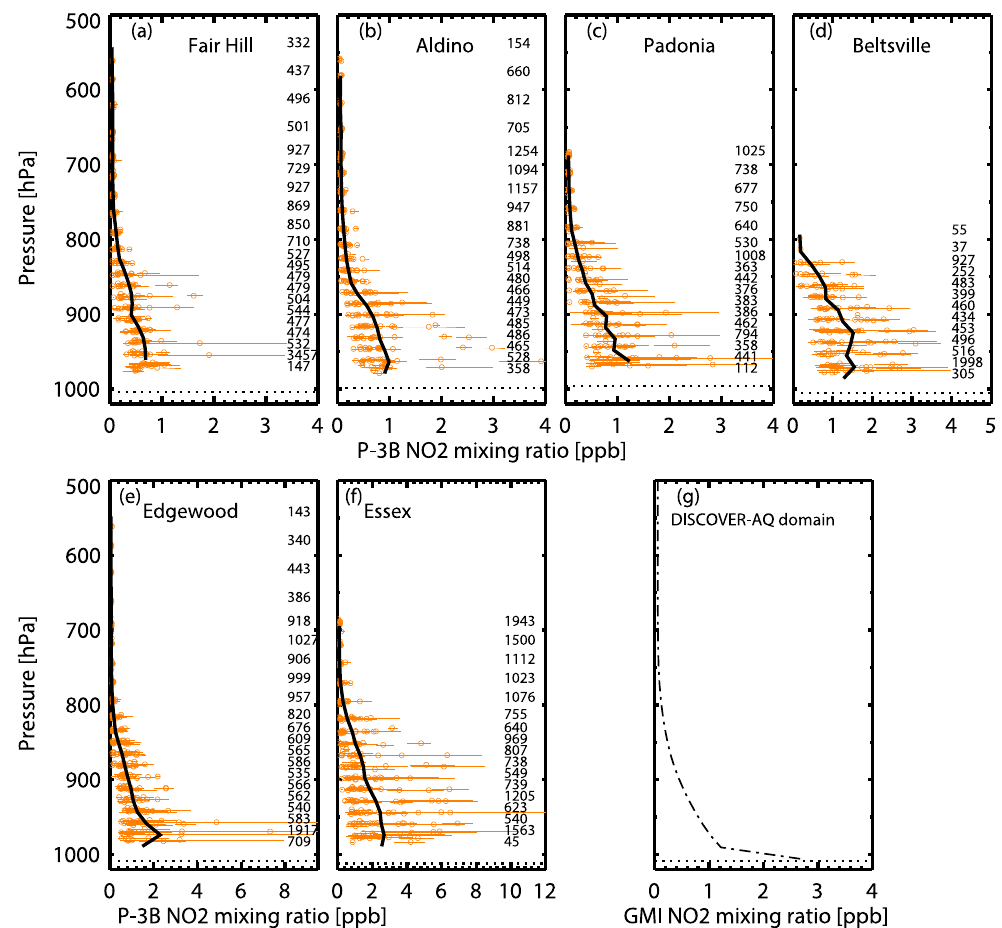
Figure 2. Early afternoon (12:00 to 15:00) vertical mean profile of NO 2 mixing ratio over Fair Hill, Aldino, Padonia, Beltsville, Edgewood, and Essex in Maryland. The open circles (in orange) represent NO 2 mixing ratios averaged over the GMI pressure grid from each spiral. Error bars represent the 10th to 90th percentiles. Solid black lines connect the mean mixing ratios determined from in situ measurements during the entire campaign. The number of measurements within each GMI pressure grid is shown in the right of each panel. The dotted lines show the surface pressure levels. The bottom-right panel shows the GMI a priori monthly (July) mean NO 2 mixing ratio profile over the DISCOVER-AQ